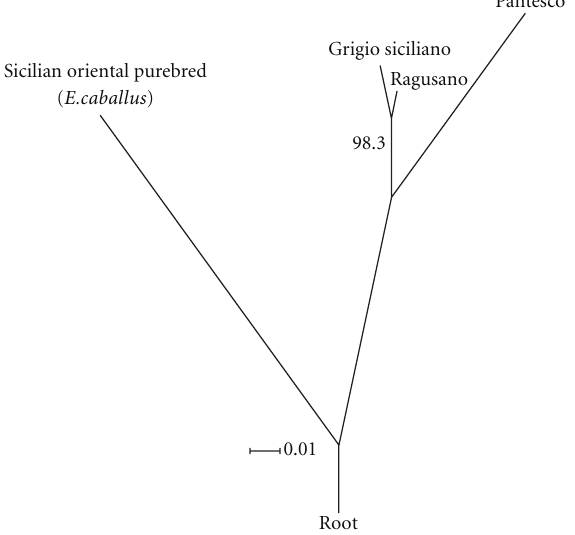
Figure 1: Neighbour-Joining rooted tree built on D R genetic distances. This is a consensus tree out of the trees resulted from 1000 bootstrap resamplings of the allele frequencies at 13 loci ’s.